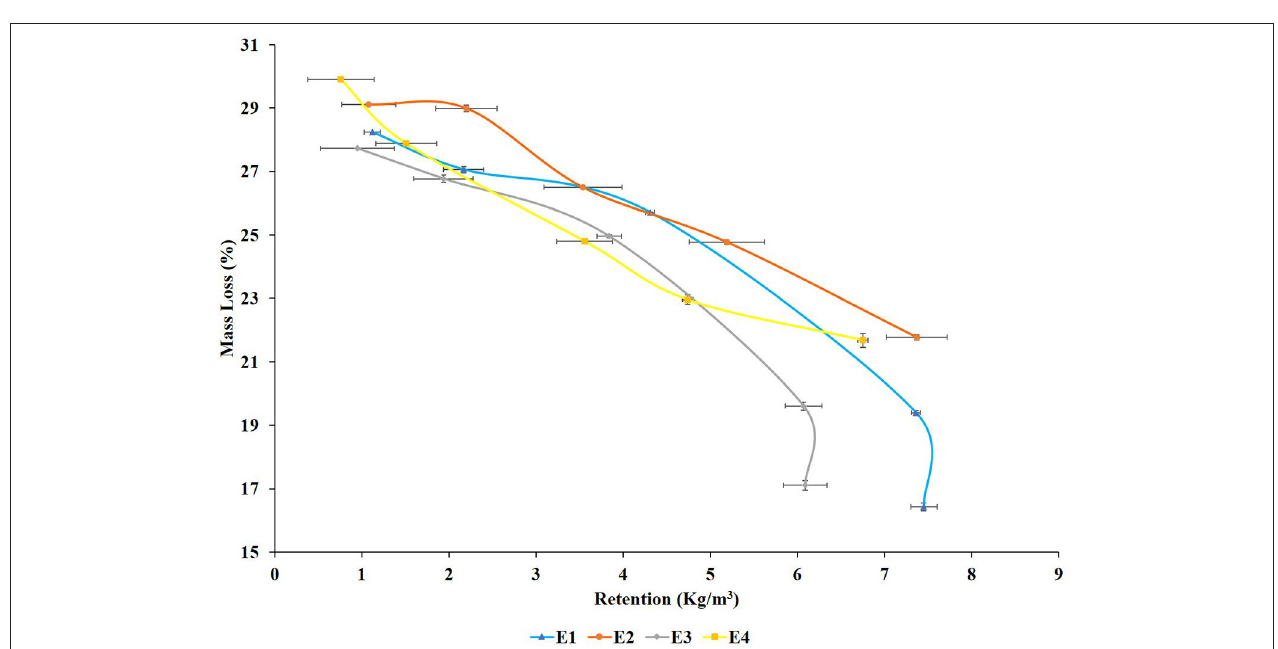
FIGURE 6 | Mass loss concerning extractive retention of Lannea coromandelica wood blocks.